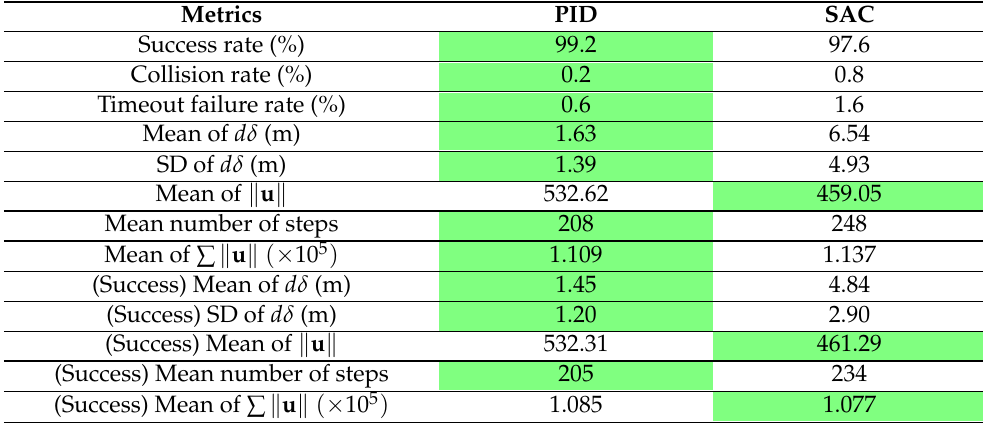
Table 7. Testing phase of a model after removing the angular and linear speeds from the state vector, trained on 1750 episodes. For each metric, the controller with the best score is highlighted in